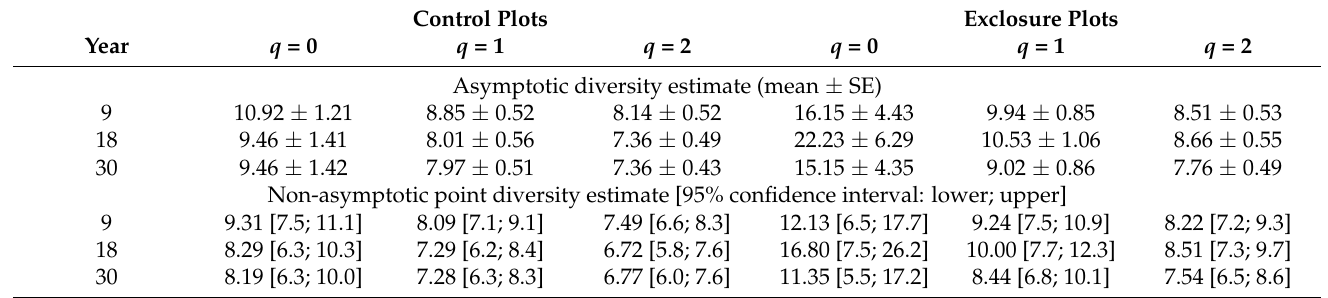
Table 2. Asymptotic and non-asymptotic diversity estimates for incidence-based tree species data collected on control and exclosure plots in Austria 9, 18, and 30 years after establishment of study plots. Non-asymptotic rarefaction and extrapolation analyses are based on point diversities for a specified sample coverage of C max = 96.3%. Numerical values for Hill numbers of order q ( q = 0, species richness; q = 1, Shannon diversity; q = 2, Simpson